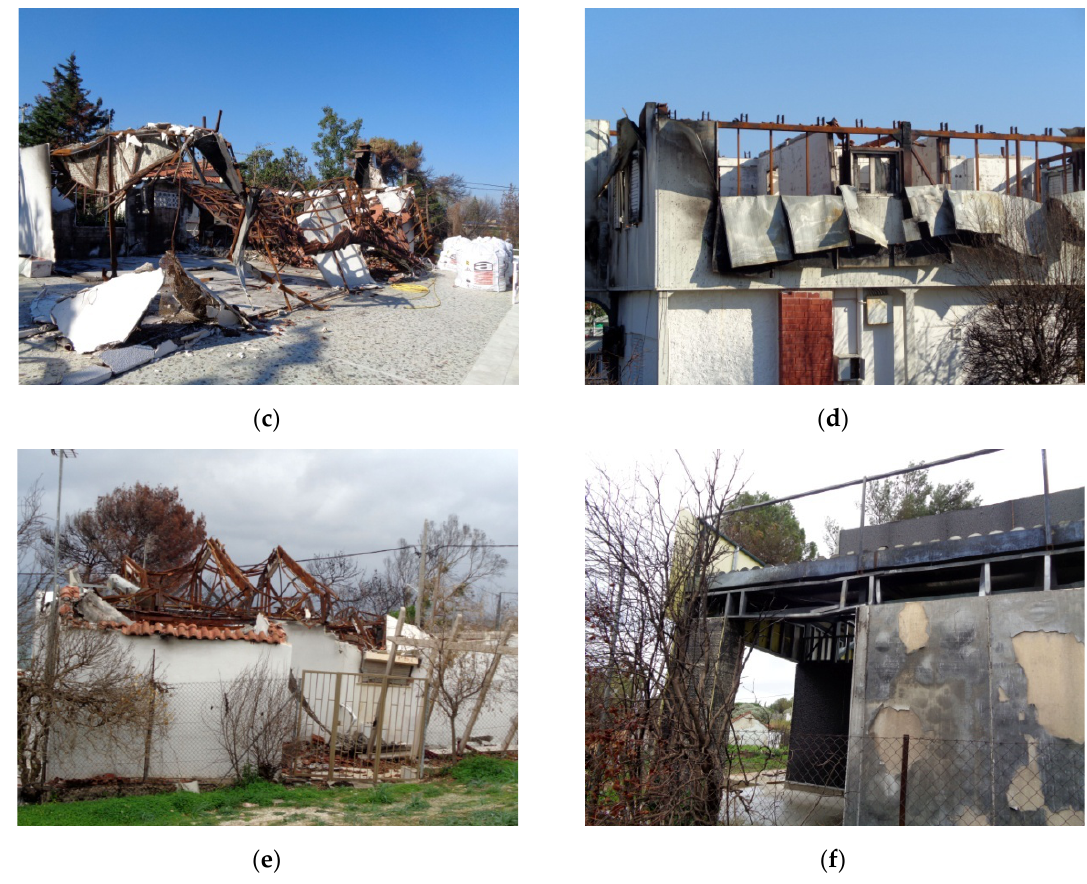
Figure 8. Photographs depicting damage that occurred in buildings with a steel frame after the wildfire in Mati: (a, b) relatively unaffected strong members; (c) corrosion and buckling of thin metal members; (d) buckling of metal panels; (e) severe damage of trusses; (f) buckling of aluminum frames.